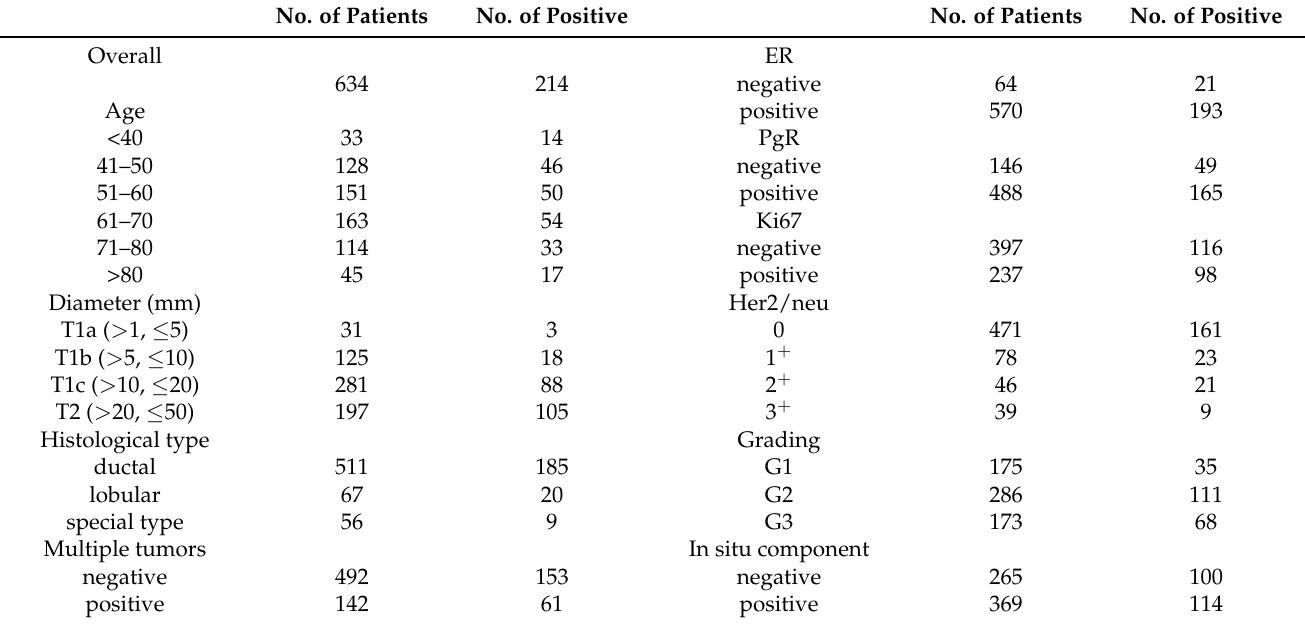
Table 1. Observed number of patients with positive lymph nodes according to the considered prognostic